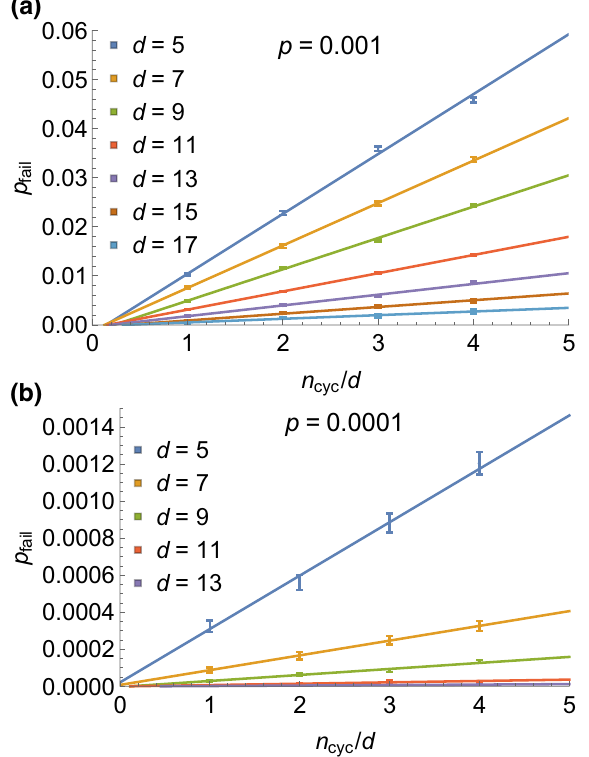
FIG. 37. Failure probability of the logical idle operation using the best-performing CNOT schedule as a function of n cyc / d for (a) p = 10 − 3 and (b) p = 10 − 4 . We use the ansatz in Eq. (13) in the main text to find the logical failure rate p ( p , d ) . We observe that QEC equilibration occurs by the d th QEC